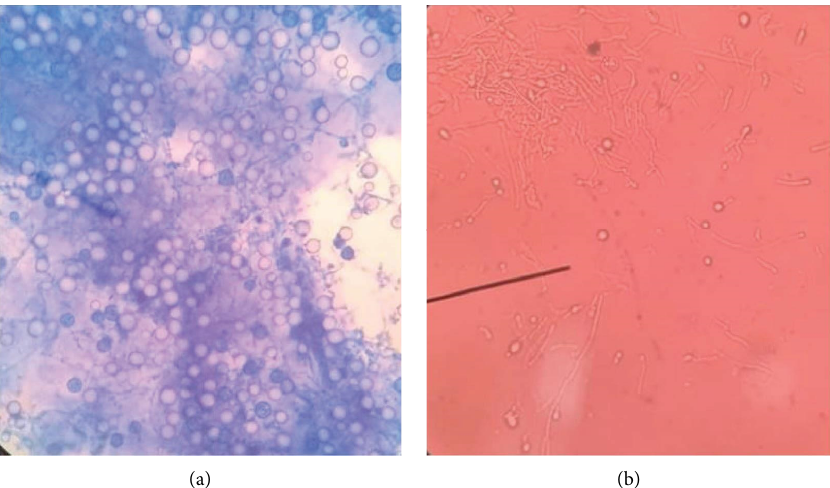
Figure 7: Histoplasma capsulatum yeast in methylene blue (a) and KOH (b) staining taken 5weeks after starting BMA culture in Sabouraud agar.